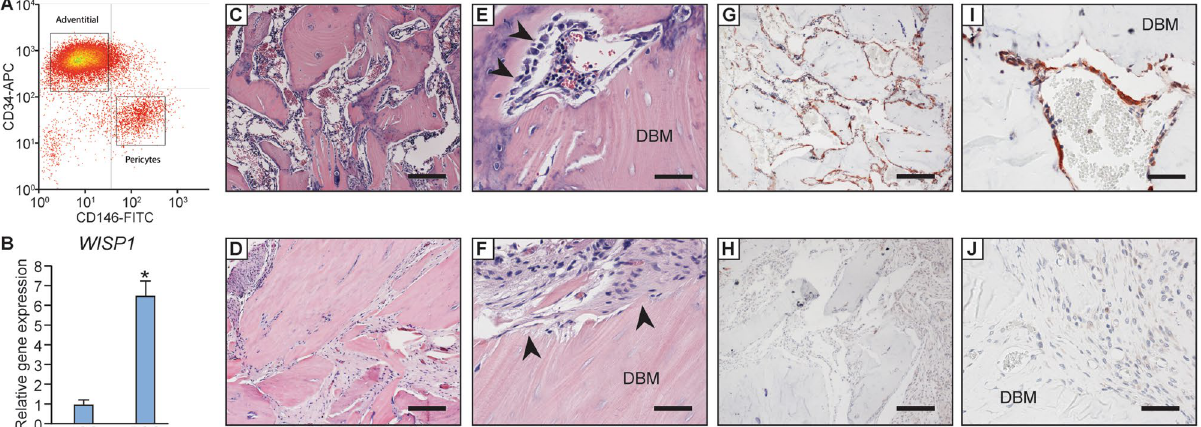
Figure 2. WISP-1 expression in human PSC after FACS isolation and upon orthopaedic transplantation. ( A ) Fluorescence activated cell sorting (FACS) of human lipoaspirate was performed per established protocols to isolate perivascular stem/stromal cells (PSC). After isolation of CD31 − CD45 − non-endothelial/ non-hematopoietic cells ( not shown ), PSC were further defined as adventitial progenitor cells (APC, CD34 + CD146 − ) or microvascular pericytes (CD146 + CD34 − ). ( B ) Quantitative RT-PCR for WISP1 transcripts, examined in passage one PSC or unpurified ASC (adipose-derived stromal cells) from the same patient sample. Performed in technical triplicate. ( C – F ) H&E appearance of rat spine fusion segments. ( C , E ) H&E appearance of PSC-treated spinal fusion segments with new bone formation, incorporation of demineralized bone matrix (DBM), and conspicuous bone-lining osteoblasts (arrowheads). ( D , F ) H&E appearance of control-treated spinal fusion segments, with little new bone formation, DBM particles without connections to each other and embedded in fibrous stroma, and inactive bone lining cells (arrowheads). ( G – J ) WISP-1 indirect immunohistochemical staining of PSC treated spine fusion segments. WISP-1 immunoreactivity appears brown, while nuclear Hematoxylin counterstain appears blue. ( G , I ) Strong WISP-1 immunoreactivity in bone lining cells among PSC treated samples. ( H , J ) Weak to intermediate WISP-1 immunoreactivity in inflammatory cells and stromal fibroblasts among control treated samples. * P < 0.05. Scale bars (parts C , D , G , H ) 25 µ m; Scale bar (parts E , F , I , J ) 100 µ m.